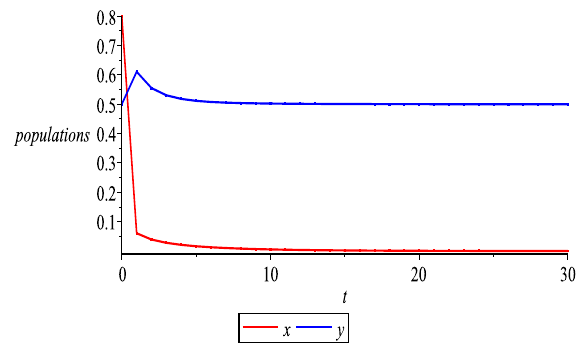
Figure 1. ( a ) The stability of interior equilibrium with initial value ( 0.8,0.5 ) . ( b ) The instability of interior equilibrium with initial value ( 0.8,0.5 ) .